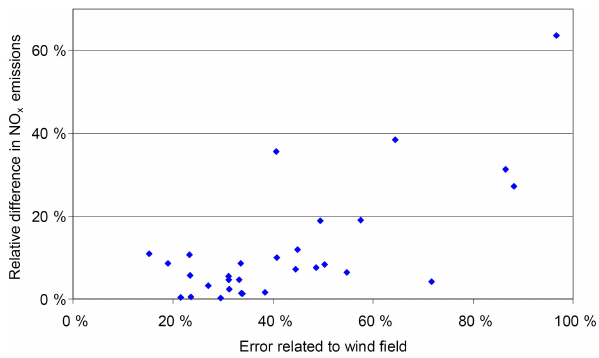
Figure 14. Ratios of the derived NO x emissions (CIM CHIMERE ) and the TNO emissions used for the model simulations. For the CIM individual partitioning ratios for the different days are used (see Sect. 4.3). The TNO emissions are averaged for the time pe- riod of the respective measurements (see text). The colours indicate different kinds of problems of the individual days (see also Table